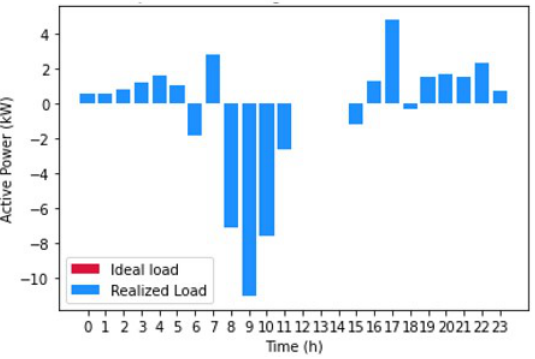
Figure 9. Behavior of the injection/load power of the microgrid observed by the network in the scenario with programmed